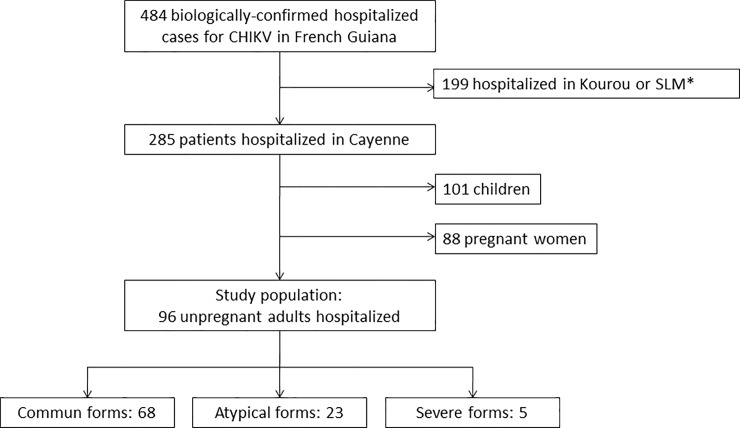
Study flow chart.*SLM: Saint Laurent du Maroni.